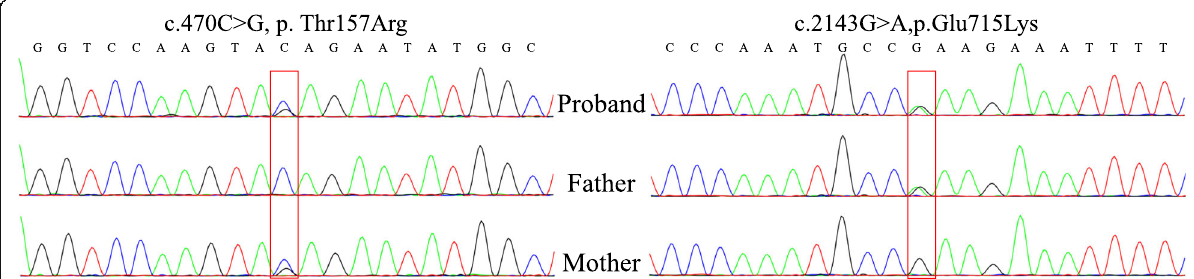
Fig. 3 The compound heterozygous variants were detected by whole-genome sequencing and confirmed by Sanger sequencing